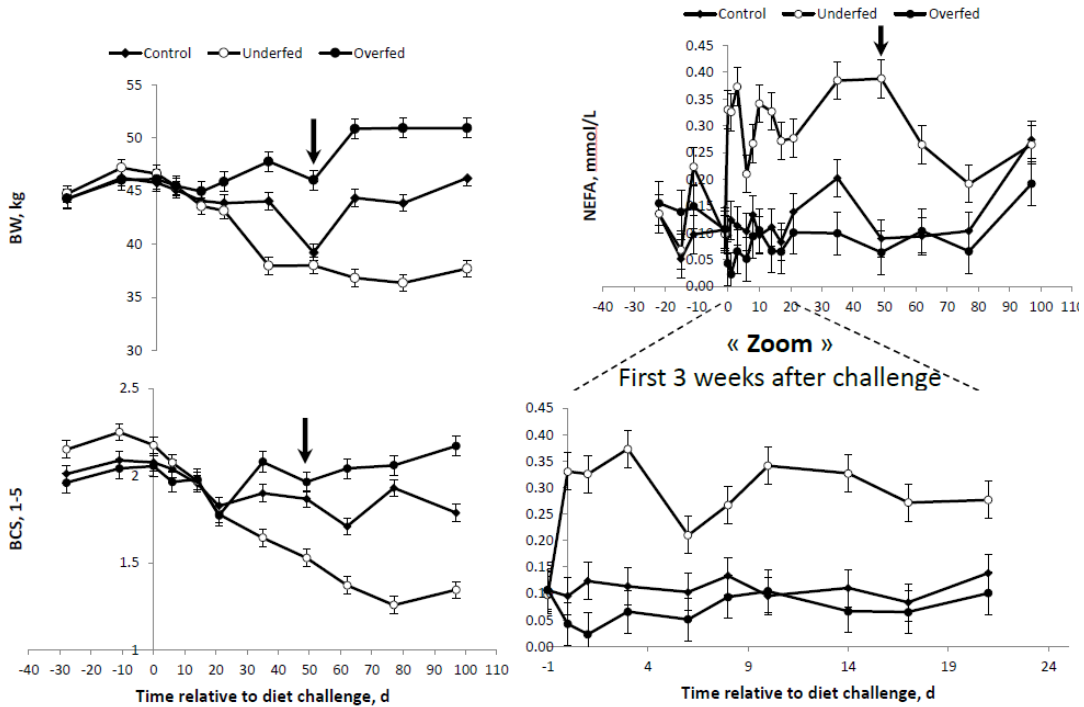
Figure 2. Body weight (BW), body condition score (BCS) and plasma free fatty acids (FFA or nonesterified (NEFA) concentrations of mature, dry, nonpregnant Merinos d’Arles ewes ( n = 36) offered 70% (underfed; n = 12), 100% (control; n = 12) or 160% (overfed; n = 12) of maintenance energy requirements. Diet challenge started at day 0, after a 3-week adaptation period. Arrow represents commencement of refeeding period. Bars are SEM.